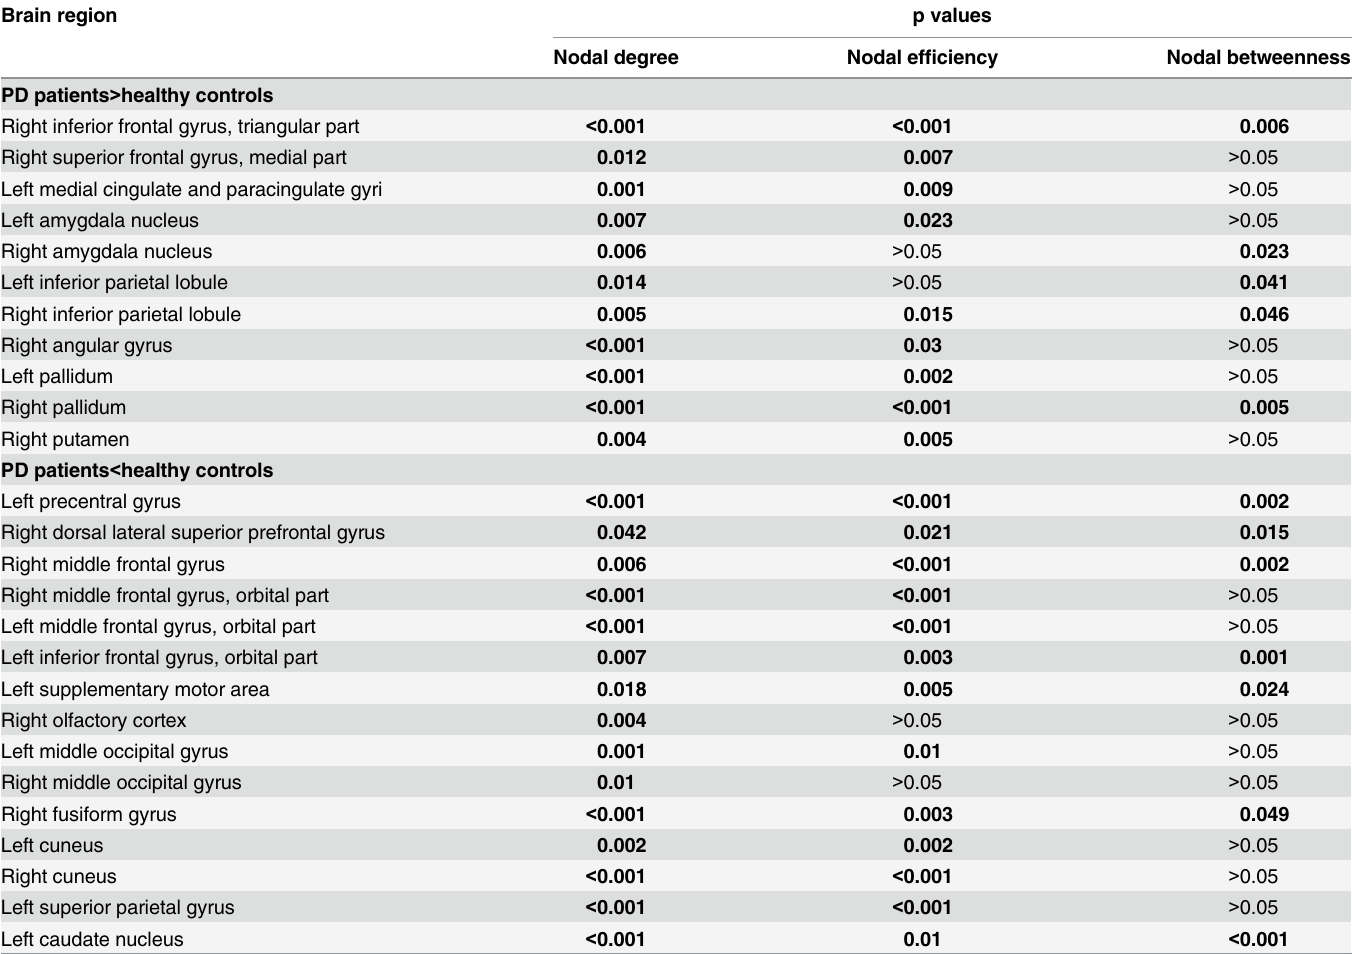
Table 2. Regions showing abnormal nodal centrality in PD patients compared with control subjects (p < 0.05, FDR-corrected, shown in bold